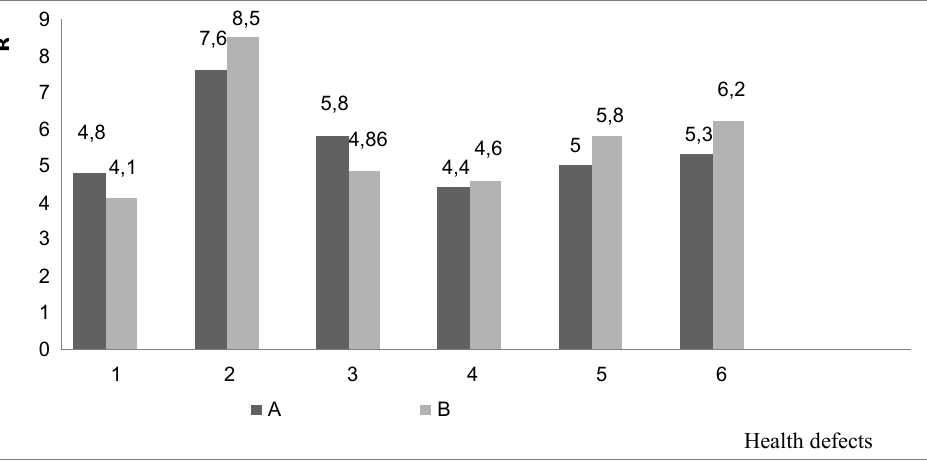
Fig.1. Physical health level of disabled students before pedagogic experiment (L.G. Apanasenko). Legend: R – physical health level; sum of points 3 and less – low level, 4-6 points – below average, 7-11 points – average level, 12-15 points – above average, 16-18 points- high level; 1 – eyesight; 2 –hearing; 3 – muscular- skeletal apparatus (MSA); 4 – cerebral palsy (CP); 5 – somatic diseases (SD); 6– diabetes (D); A - students; B –girl-